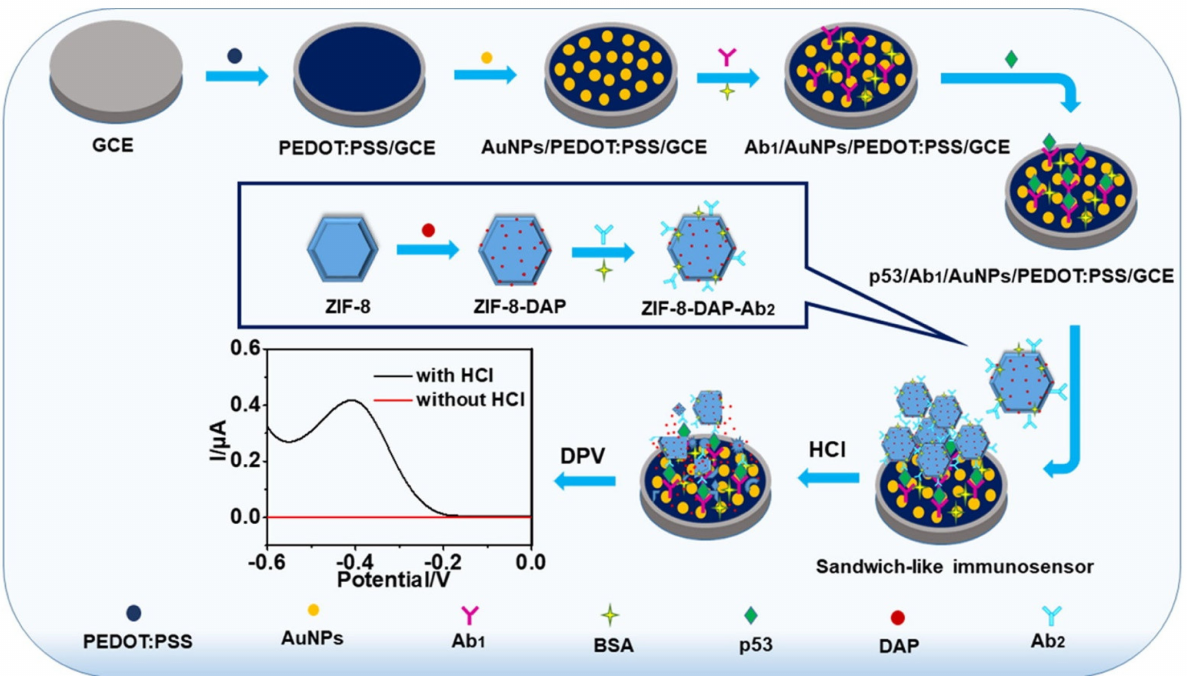
Figure 17. Electrochemical immunosensing process for detecting p53. PEDOT: PSS: poly (3, 4– ethylenedioxythiophene): polystyrenesulfonate; DAP: 2, 3–diaminophenazine; ZIF–8: Zeolitic Imida- zolate framework-8; Ab1: primary antibody; Ab2: secondary antibody. Reprinted with permission from [119], published by Elsevier,